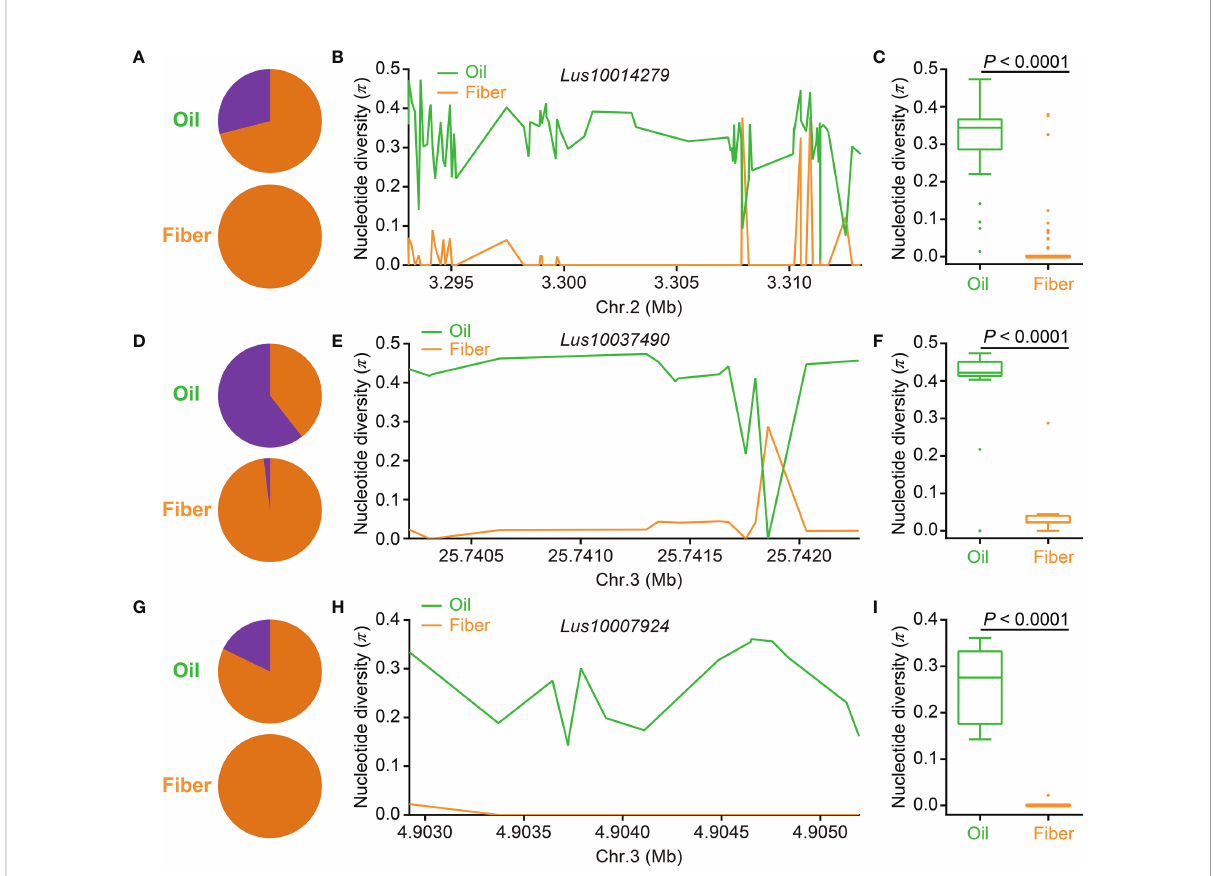
FIGURE 6 Distribution of nucleotide diversity ( p ) and allele frequency in three seed size – related candidate differentially expressed genes (DEGs) identi fi ed by a DEG-based association study between the oil fl ax and fi ber fl ax subgroups. (A, D, G) Allele frequency distribution of single-nucleotide polymorphisms (SNPs) located in Lus10014279 (A) , Lus10037490 (D) , and Lus10007924 (G) in the oil fl ax (green) and fi ber fl ax (orange) subgroups. The proportions of large-seed and small-seed alleles are indicated by purple and orange colors, respectively. (B, E, H) Distribution of the p of Lus10014279 on chromosome 2 (B) , Lus10037490 on chromosome 3 (E) , and Lus10007924 (H) on chromosome 3 between the oil fl ax and fi ber fl ax subgroups. (C, F, I) Box plots for the p of Lus10014279 (C) , Lus10037490 (F) , and Lus10007924 (I) in the oil fl ax and fi ber fl ax subgroups. The difference was analyzed by two-tailed t -tests. Chr.,